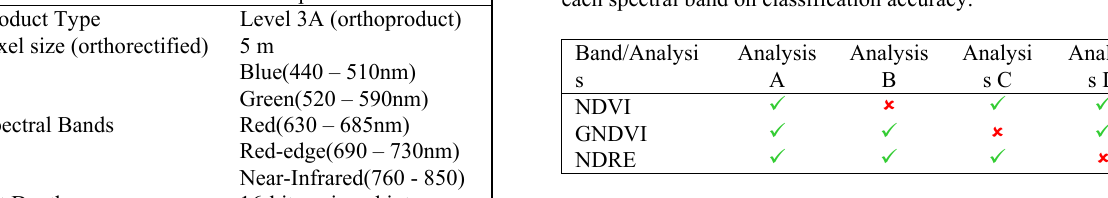
Table 3.Sets of spectral